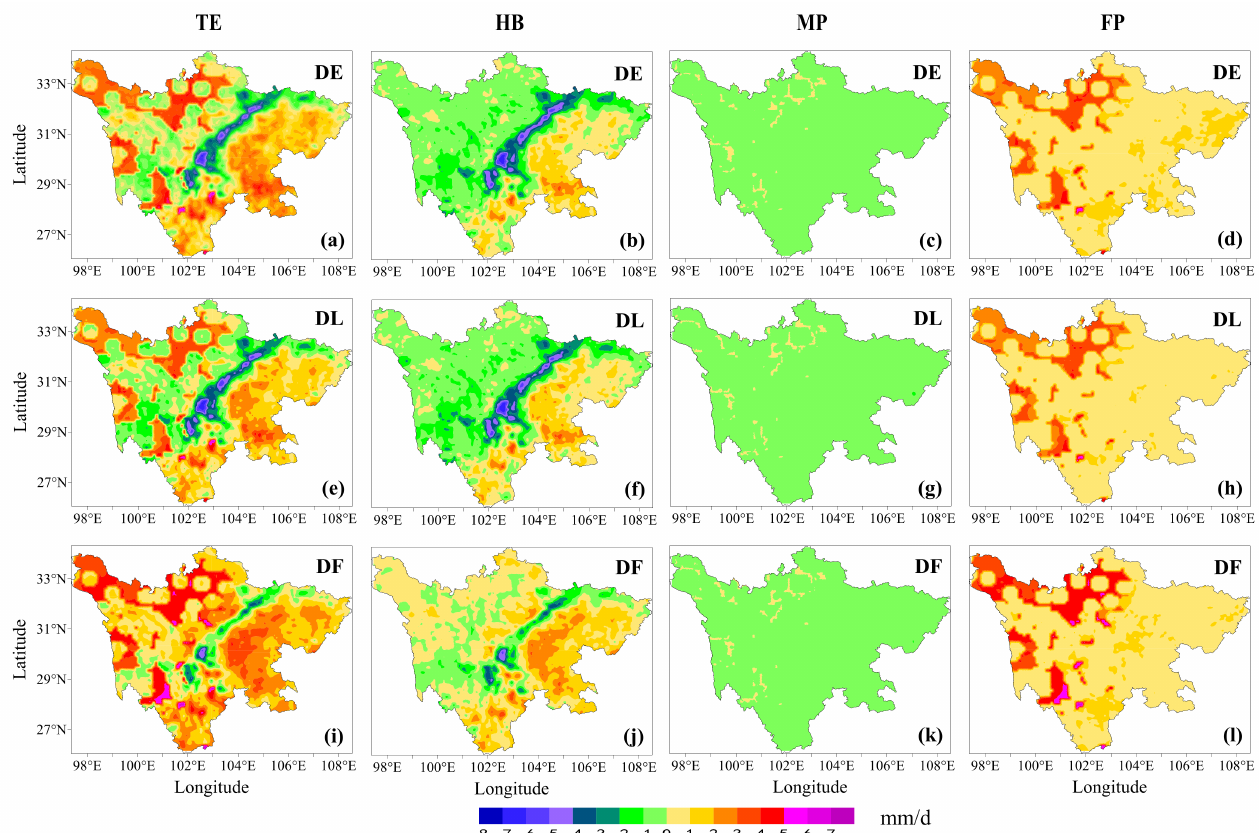
Figure 7. Spatial distributions of mean errors components for the three IMERG estimates: columns from left to right are ( a , e , i ) total errors (TE), ( b , f , j ) hit bias (HB), ( c , g , k ) missed precipitation (MP), and ( d , h , l ) false precipitation (FP), respectively; rows from top down are IMERG-DE, IMERG-DL, and IMERG-DF, respectively. The error components are related by TE = HB + MP + FP, all in